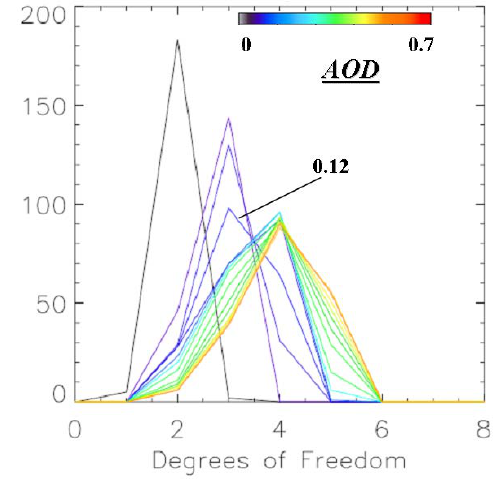
Fig. 3. Histogram for various scenarios (y-axis) of the number of Fig. 3 Histogram for various scenarios (Y-Axis) of the number of DFS of reflectance DFS of reflectance measurements for aerosol models as a function measurements for aerosol models as a function of Aerosol Optical Depth (AOD) for a case with surface albedo spectra for soil. of Aerosol Optical Depth (AOD) for a case with surface albedo spectra for